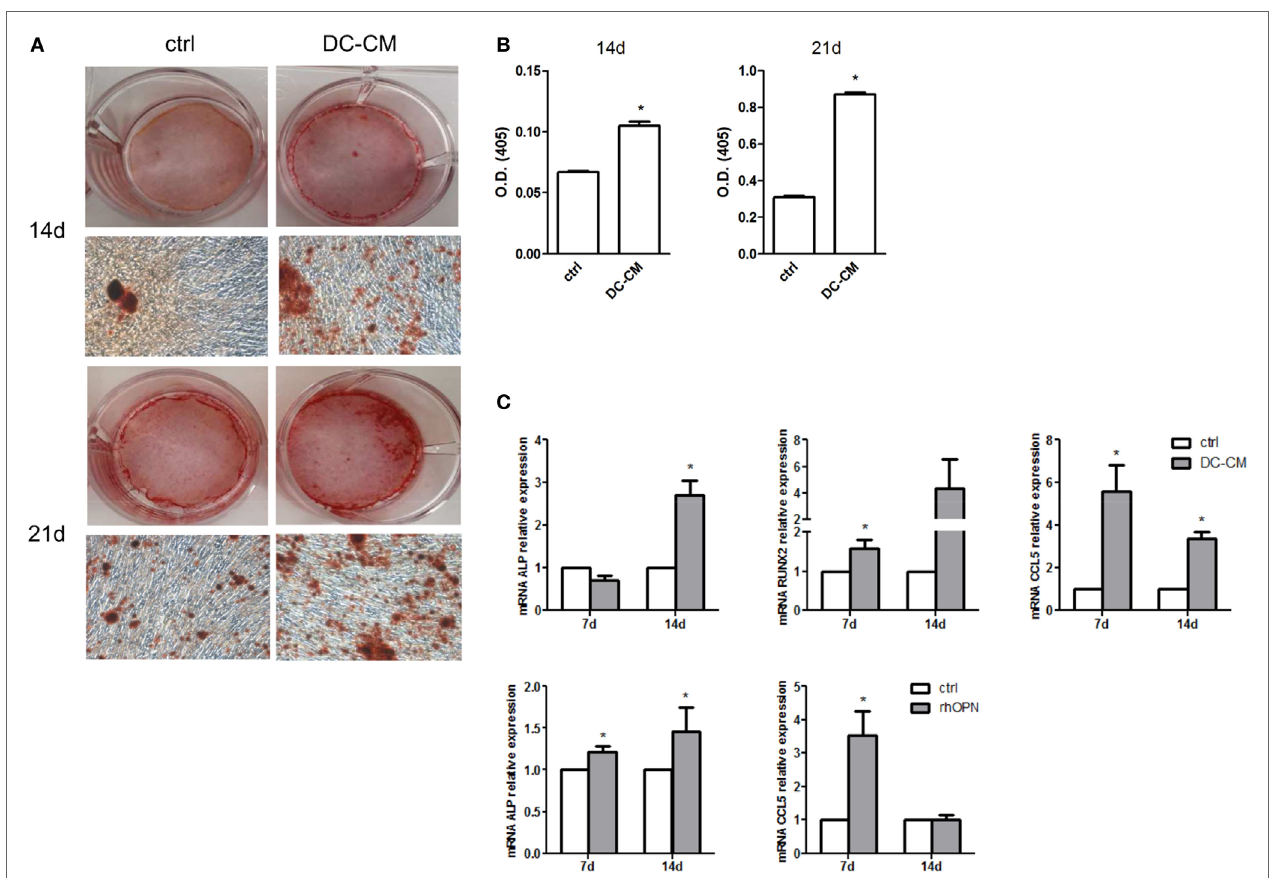
FigUre 4 | DC-conditioned medium induces mesenchymal stromal cells (MSC) differentiation into osteoblasts through osteopontin release. (a) MSCs were cultured for 14 and 21 days in osteogenic differentiation medium in the presence of 30% DC-CM or RPMI (control condition, ctrl) and stained with Alizarin Red S to identify mineralized deposits. (B) Quantification of Alizarin Red staining via dissolving the dye and measurement of subsequent absorption at optical density of 405 nm. * p < 0.05 vs. ctrl by Student’s t -test. (c) The mRNA levels of alkaline phosphatase , RUNX, and CCL5 were analyzed by real-time PCR at days 7 and 14 of culture of MSC in presence of DC-CM or rhOPN. RPL13A was used for normalization. Data were shown as means ± SEM ( n = 3). * p < 0.05 vs. ctrl by Student’s t -test.